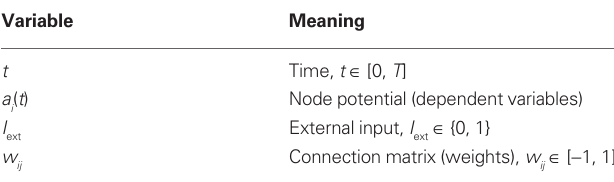
Table A1 | Variable names occurring in the formulation of the model.